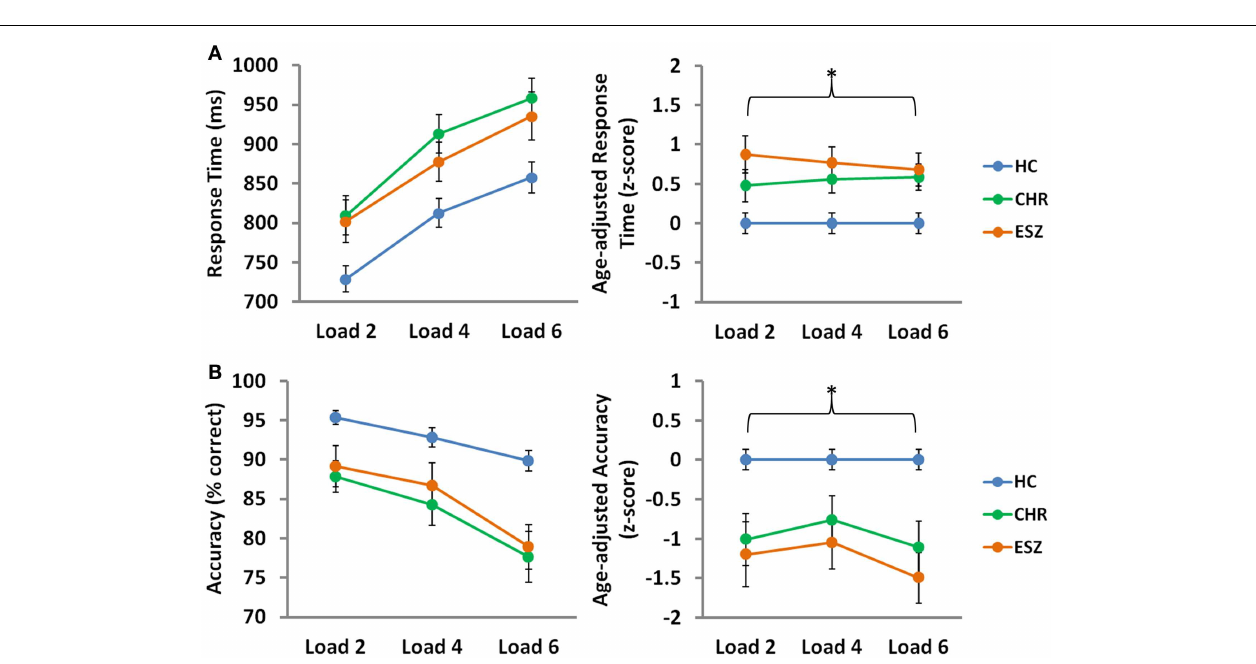
FIGURE 1 | Behavioral Data by Group for low (two-item), medium (four-item), and high (six-item) working memory loads during the probe condition. HC = healthy control; CHR = clinical high-risk; ESZ = early schizophrenia. Median response time ( ± standard error) is shown in the top panel and mean accuracy ( ± standard error) is shown in the bottom panel by Group, for unadjusted (left) and age-adjusted (right) data.° °Statistical tests of behavioral data (* p <